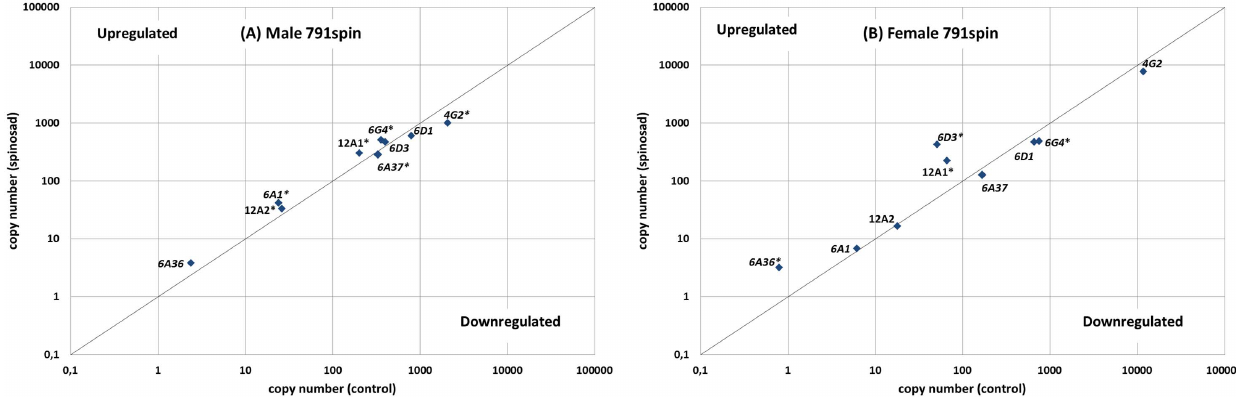
Figure 2. 791spin male (A) and female (B) spinosad-influenced gene expression as a function of the constitutive gene expression. The line represents no effect of spinosad exposure. Genes in right-lower and left-upper corner are down-regulated and up-regulated by spinosad, respectively. Points marked with * are significantly different from the separation line by a =0.05.